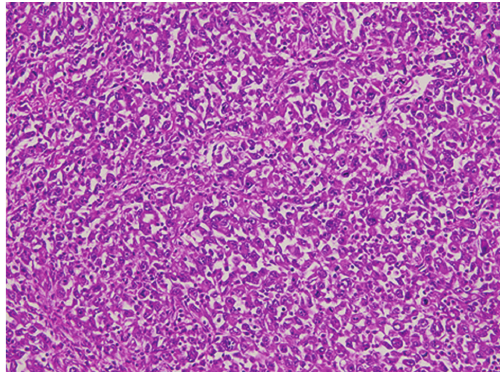
Figure 3: The tumor cells had eosinophilic cytoplasm and distinc- tive nucleoli that showed mitosis in some parts. (H and E ×400